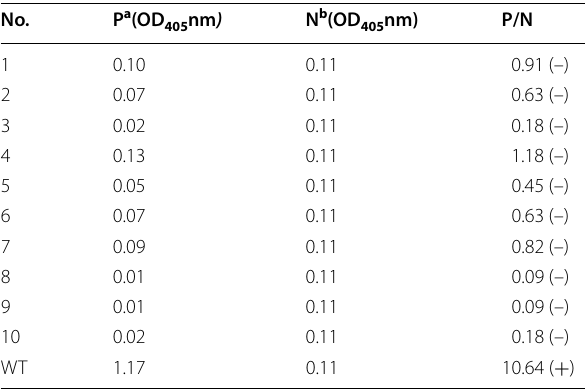
plants based 2 ) 405nm